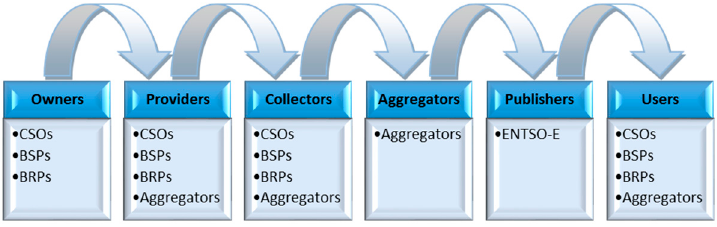
Figure 7 . Actors and their roles in relation to data and information. Figure 7. Actors and their roles in relation to data and